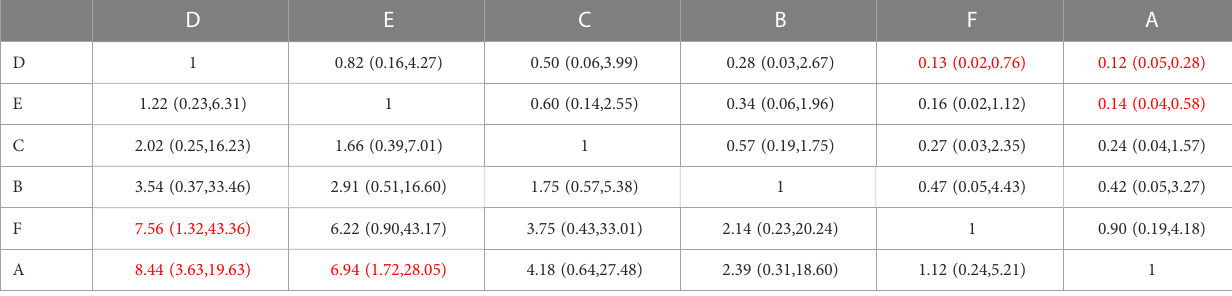
MD, standard mean difference. Red texts indicated that there were statistical difference between groups corresponding to horizontal and vertical